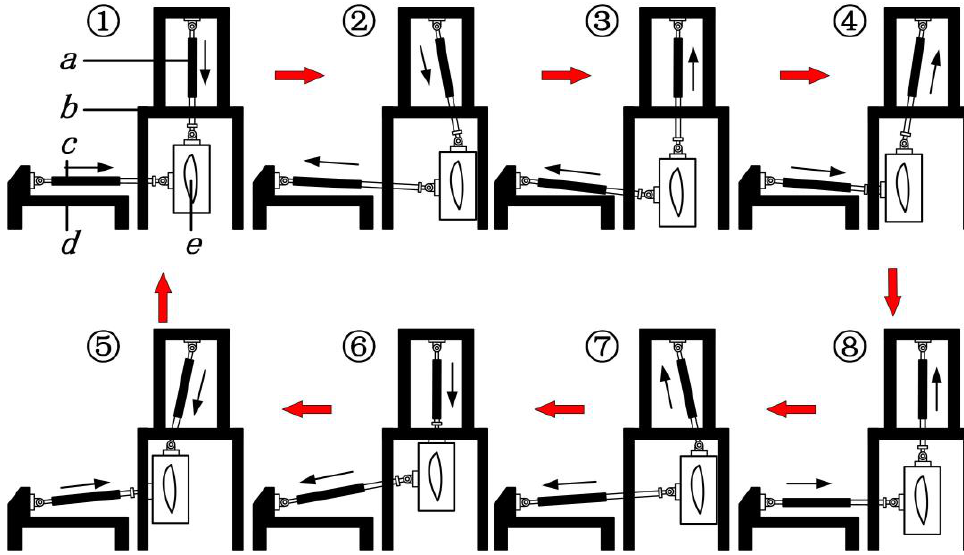
Figure 6. Movement process of blades in a single cycle when using forced displacement biaxial testing device. a is hydraulic loader of edgewise, b is support frame, c is hydraulic loader of flap- wise, d is support frame, e is cross section of blade and fixture.